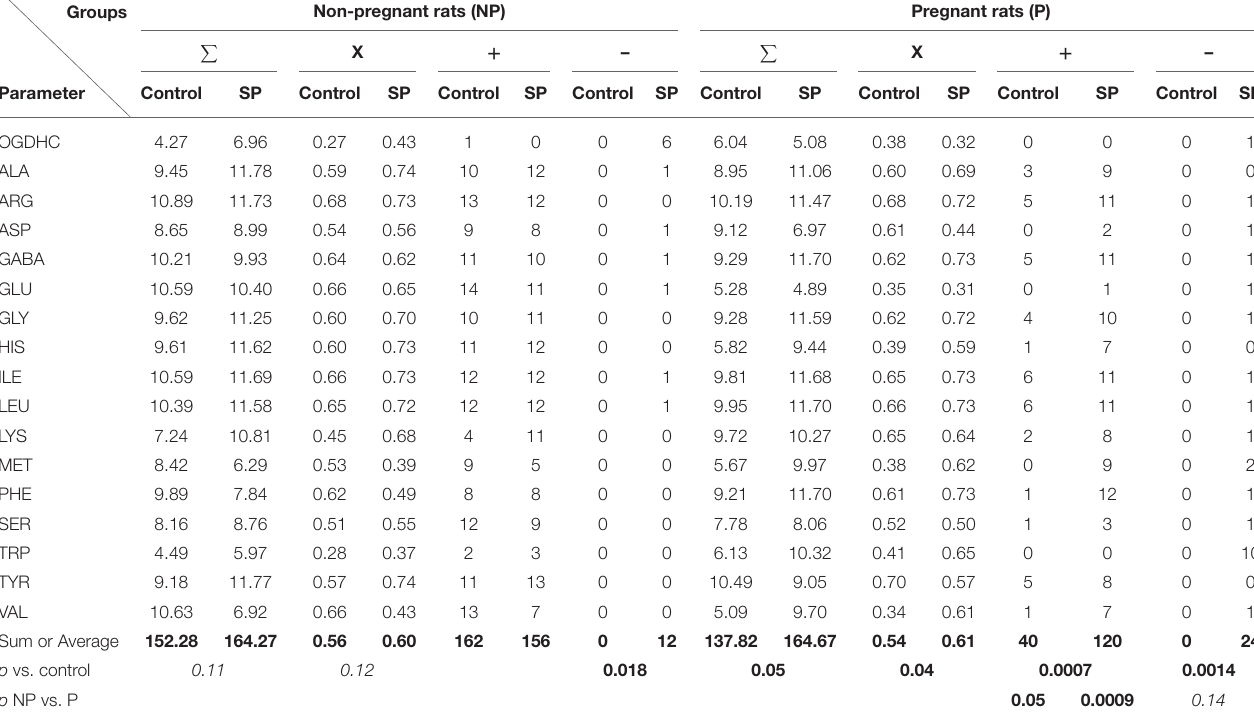
TABLE 1 | Analysis of the succinyl phosphonate SP-induced changes in interdependence of the levels of amino acids and OGDHC activity in cerebella of the NP and P rats. Groups